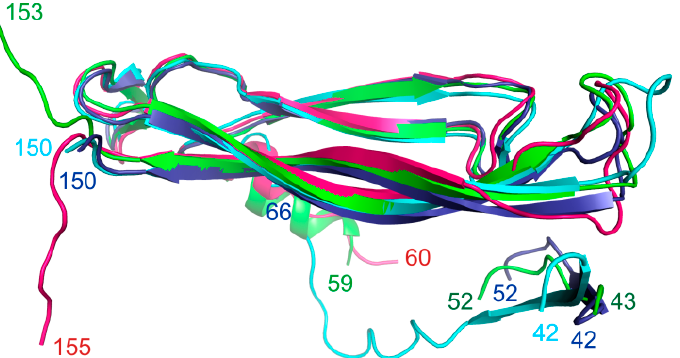
Figure 6. The mobility of structural elements of IL-17A in a free state and in complexes with ligands. Superposition of the structures: IL-17A (PDB code 4HR9) is dark blue, IL-17A/IL-17RA (PDB code 4HSA)—blue, IL-17A/secukinumab Fab fragment (PDB code 6WIO)—red, and IL-17A/anti-IL-17A-76 (PDB code 8B7W)—green.